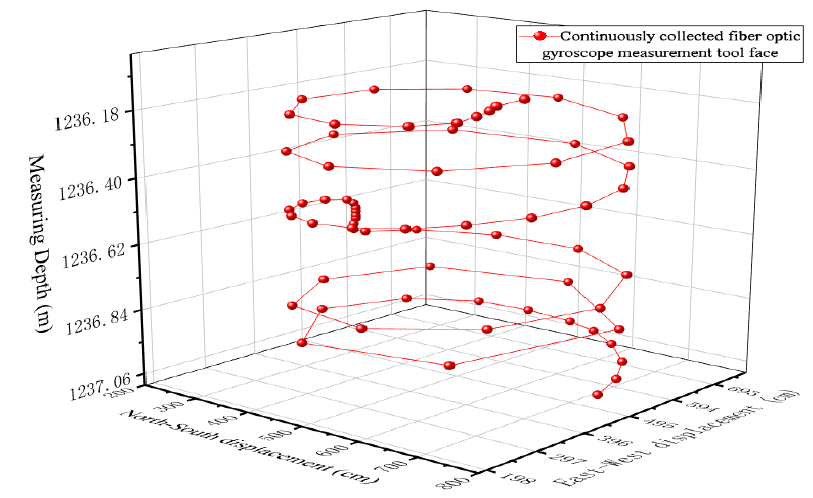
Figure 1. Measuring tool surface for downhole recording.